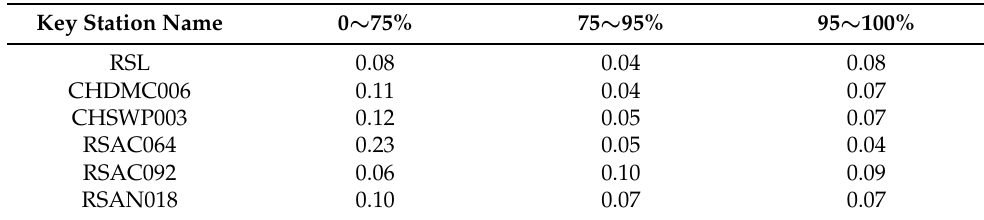
Table A6. Standard deviation of LSTM G model predictions ( σ ANN ) for six key stations. S t linearly normalized according to Equation